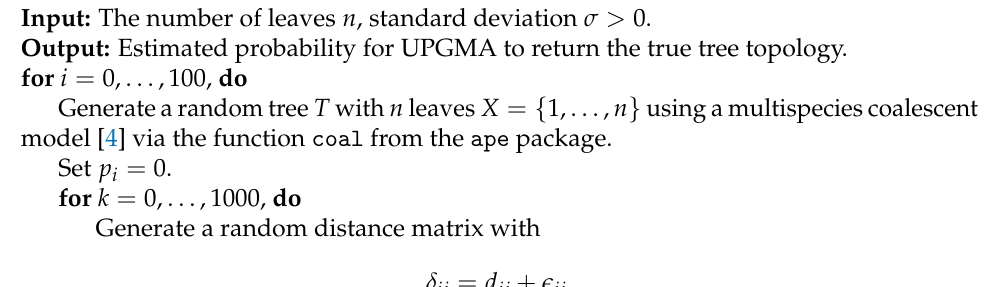
Algorithm 2 Computational experiments for estimating the probability for UPGMA to return the true tree